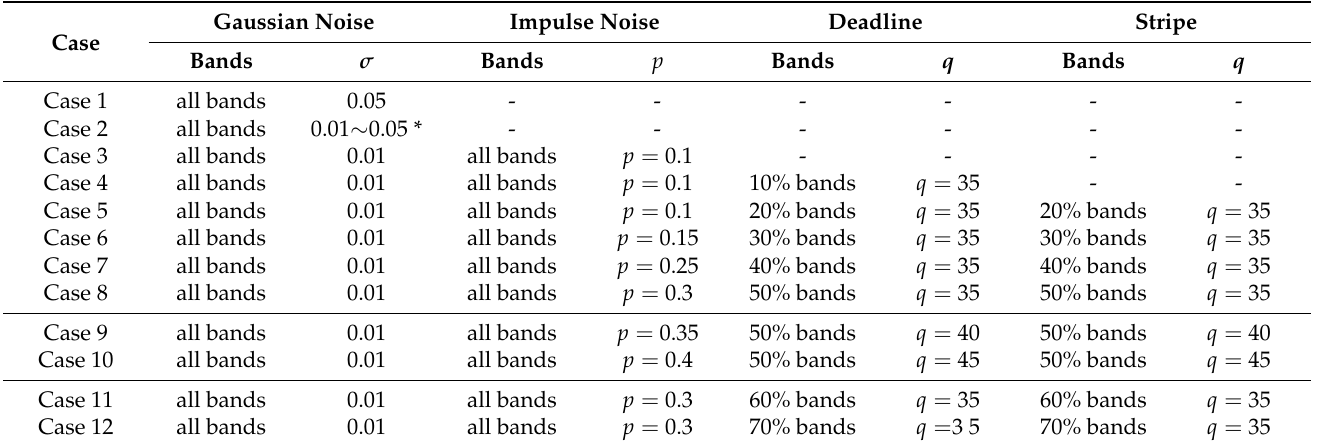
Table 1. Synthetic noise setting. σ denotes the standard deviation of Gaussian noise. p denotes the sampling rate of impulse noise. q is the number of deadlines and